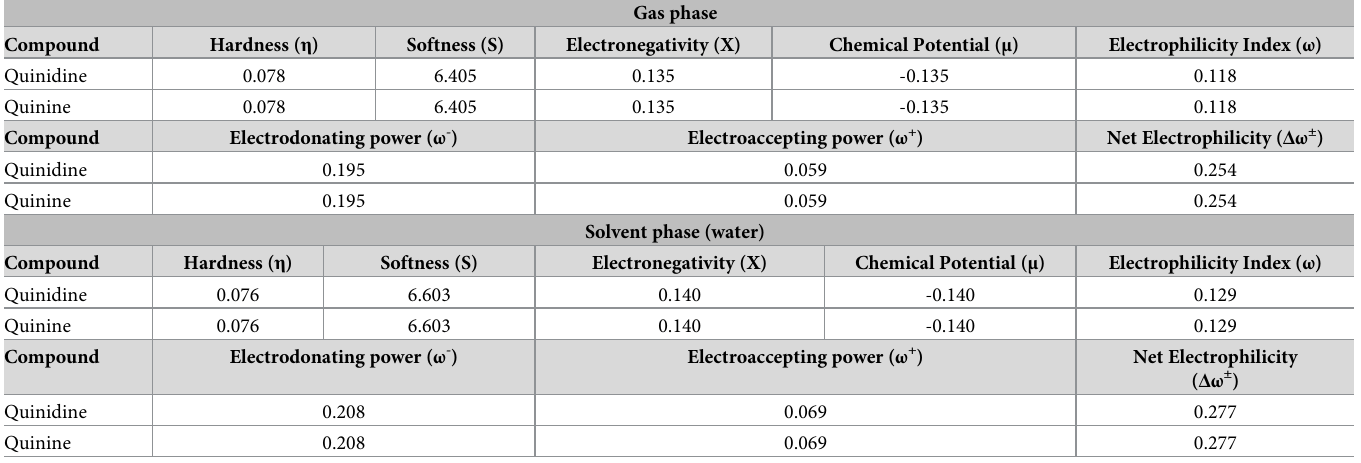
Table 2. Quantum chemical descriptors of quinolone derivatives in gas